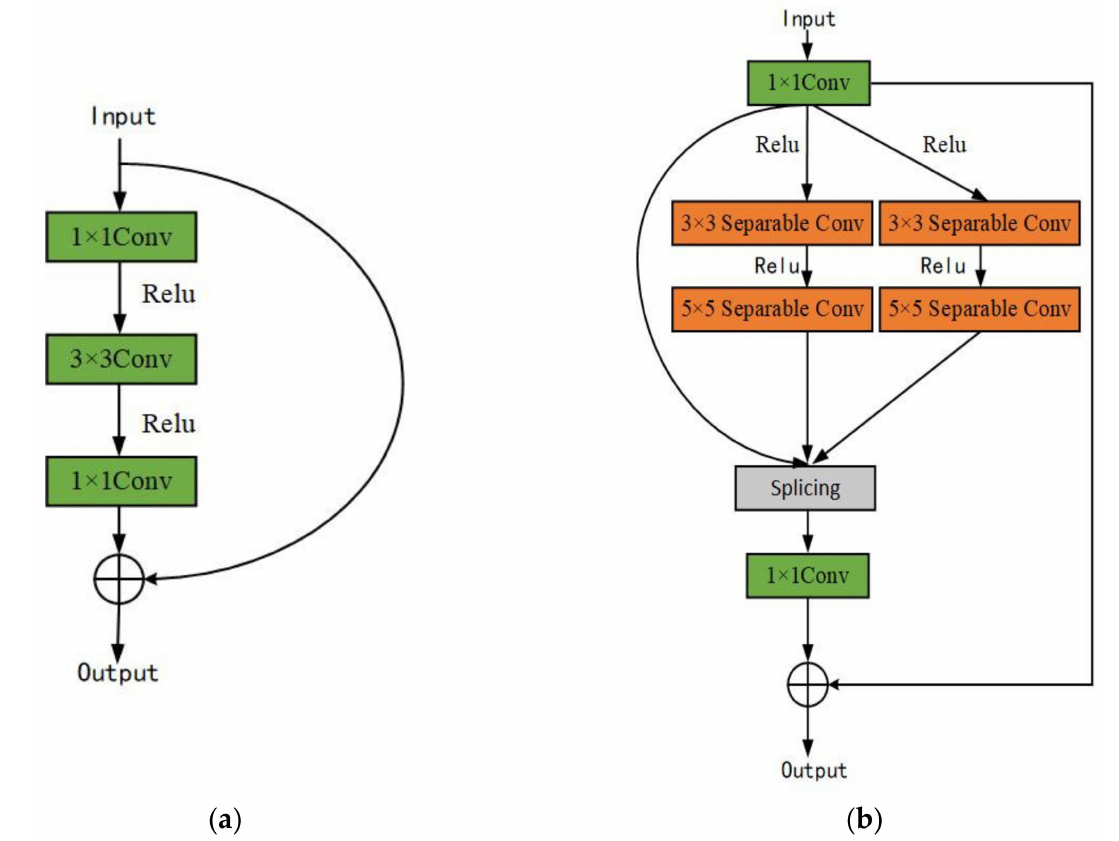
Figure 2. Ordinary residual block and separable residual block. ( a ) Ordinary residual block; ( b ) separable residual